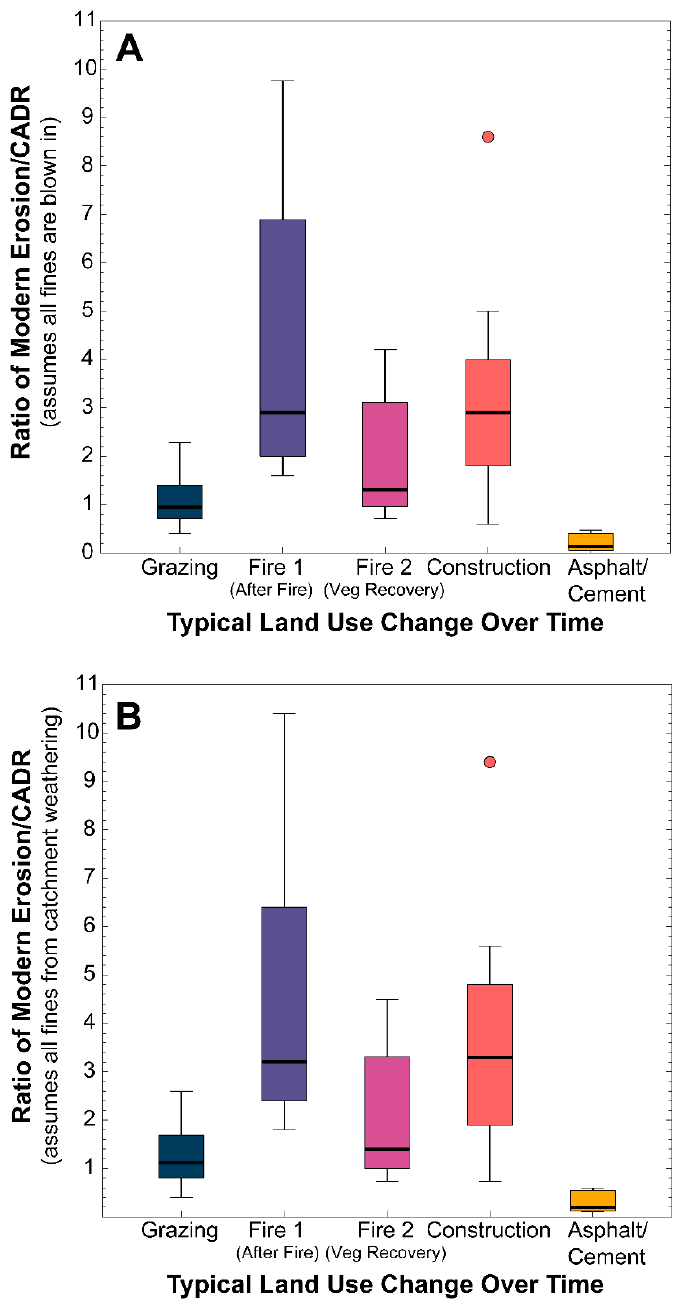
Figure 8. A comparison of the acceleration of specific sediment yields above natural backgrounds by different land uses in the Phoenix metropolitan area. The ratio was constructed from: ( A ) the minimum area-specific sediment yield calculated with the assumption that all fines are blown in divided by the CADR (i.e., the minimum acceleration in Table 6); and ( B ) the maximum area-specific sediment yield calculated with the assumption that all fines are from catchment weathering divided by the CADR (i.e., the maximum acceleration in Table 6).